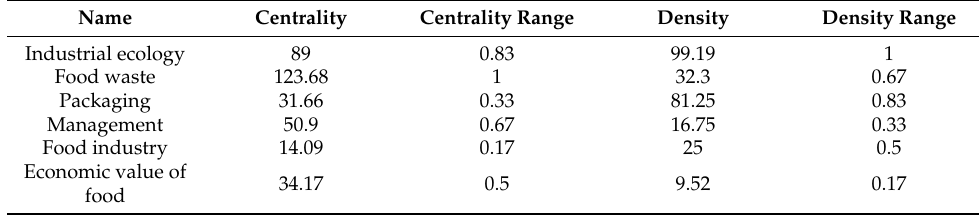
Table 3. Cluster